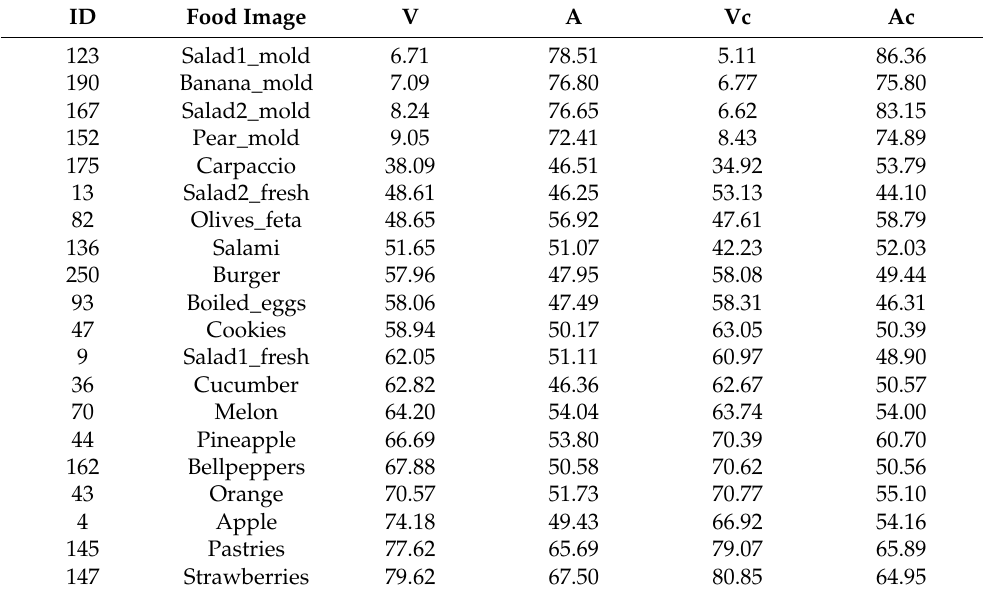
Table 1. The mean valence (V) and arousal (A) ratings resulting from the Image2Grid task and the corresponding values provided in the CROCUFID database (Vc, Ac; [40]) for each of the 20 selected food images (ID is the original image identifier in the CROCUFID database, the index c refers to values from the CROCUFID